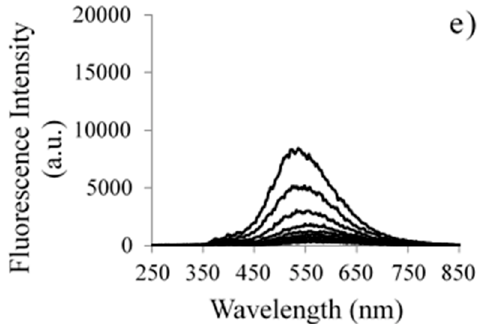
Figure 6. Time resolved laser induced luminescence spectra, at 77 K, of: anatase undoped ( a ); doped with N ( b ); doped with 2% Y ( c ); codoped with 2% ( d ) and 4% of Y-N ( e ). The excitation wavelength was 337 nm. The initial curve was obtained immediately after the laser pulse, and, for all of other curves, the time step was 20 ns annealed at 400 °C.